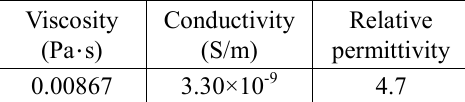
Table1 Physical properties of DBS at